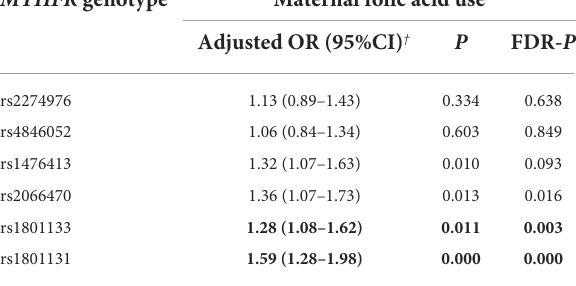
TABLE 3 Multiplicative interaction between SNPs of the MTHFR gene and maternal folic acid use detected by logistic regression. MTHFR